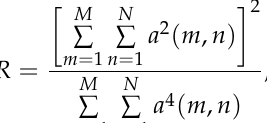
Figure 3. Training models and simulated data. ( a ) Training models. ( b ) Simulated data.